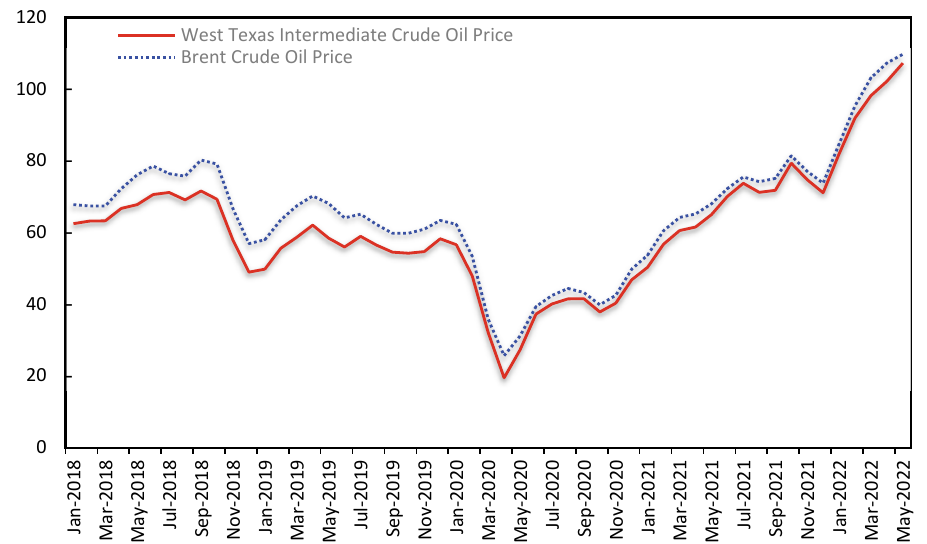
Figure 2. Trend in International Oil Prices. On the other hand, the ongoing discussion over global climate change will influence oil demand forecasts. If the world continues on its present trajectory of carbon emission intensity and greenhouse gas rises, one-third of the global population might experience excessive heat by 2070, according to Xu et al. [5]. In this context, the Chinese government has proposed a carbon peak target for 2030, a carbon neutral vision for 2060, and new initiatives to increase the country’s autonomous contribution, which not only demonstrates China’s great power role in combating global climate change but also demonstrates the severe test of China’s development posed by international public opinion pressure and green trade barriers in the external environment [6]. Attaining carbon peak and carbon neutral objectives is a long-term, slow, and difficult process, and aggressive emission reduction strategies may create classic oil security shocks, such as increasing oil prices [7]. Although oil makes for a relatively small fraction of China’s primary energy consumption now, overall oil consumption is significant and the amount of oil imports is substantial. With the further optimization of China’s economy and energy structure, oil demand will stay robust for a period of time in the future, and thus the proportion of oil used will climb substantially [8]. In the process of a rapid low-carbon energy transition, China will unavoidably face short- or medium-term oil security threats. To combine the concerns of oil security assurance with low-carbon growth is a desirable endeavor. Experience has demonstrated that a variety of climate policies, such as GHG emission reduction targets and emission regulations, can serve as essential incentives to combat climate change but can be counterproductive if the implementation process is flawed [9]. Carbon taxes and carbon trading are the primary economic measures implemented internationally to decrease carbon emissions [10,11]. The national carbon emission trading market was formally inaugurated on July 16, 2021, marking a new phase in China’s carbon emission administration. The carbon tax is an environmental tax placed on the quantity of carbon in fossil fuels or carbon dioxide emissions; however, China has not yet implemented carbon tax policies into national carbon emission reduction initiatives. Although China’s carbon market is projected to be expanded in the future to cover petrochemicals, chemicals, building materials, aviation, and other vital industries, sources accounting for 50% of the country’s total carbon emissions will not be included [12]. In this context, carbon tax, as an additional essential measure of emission reduction, has a